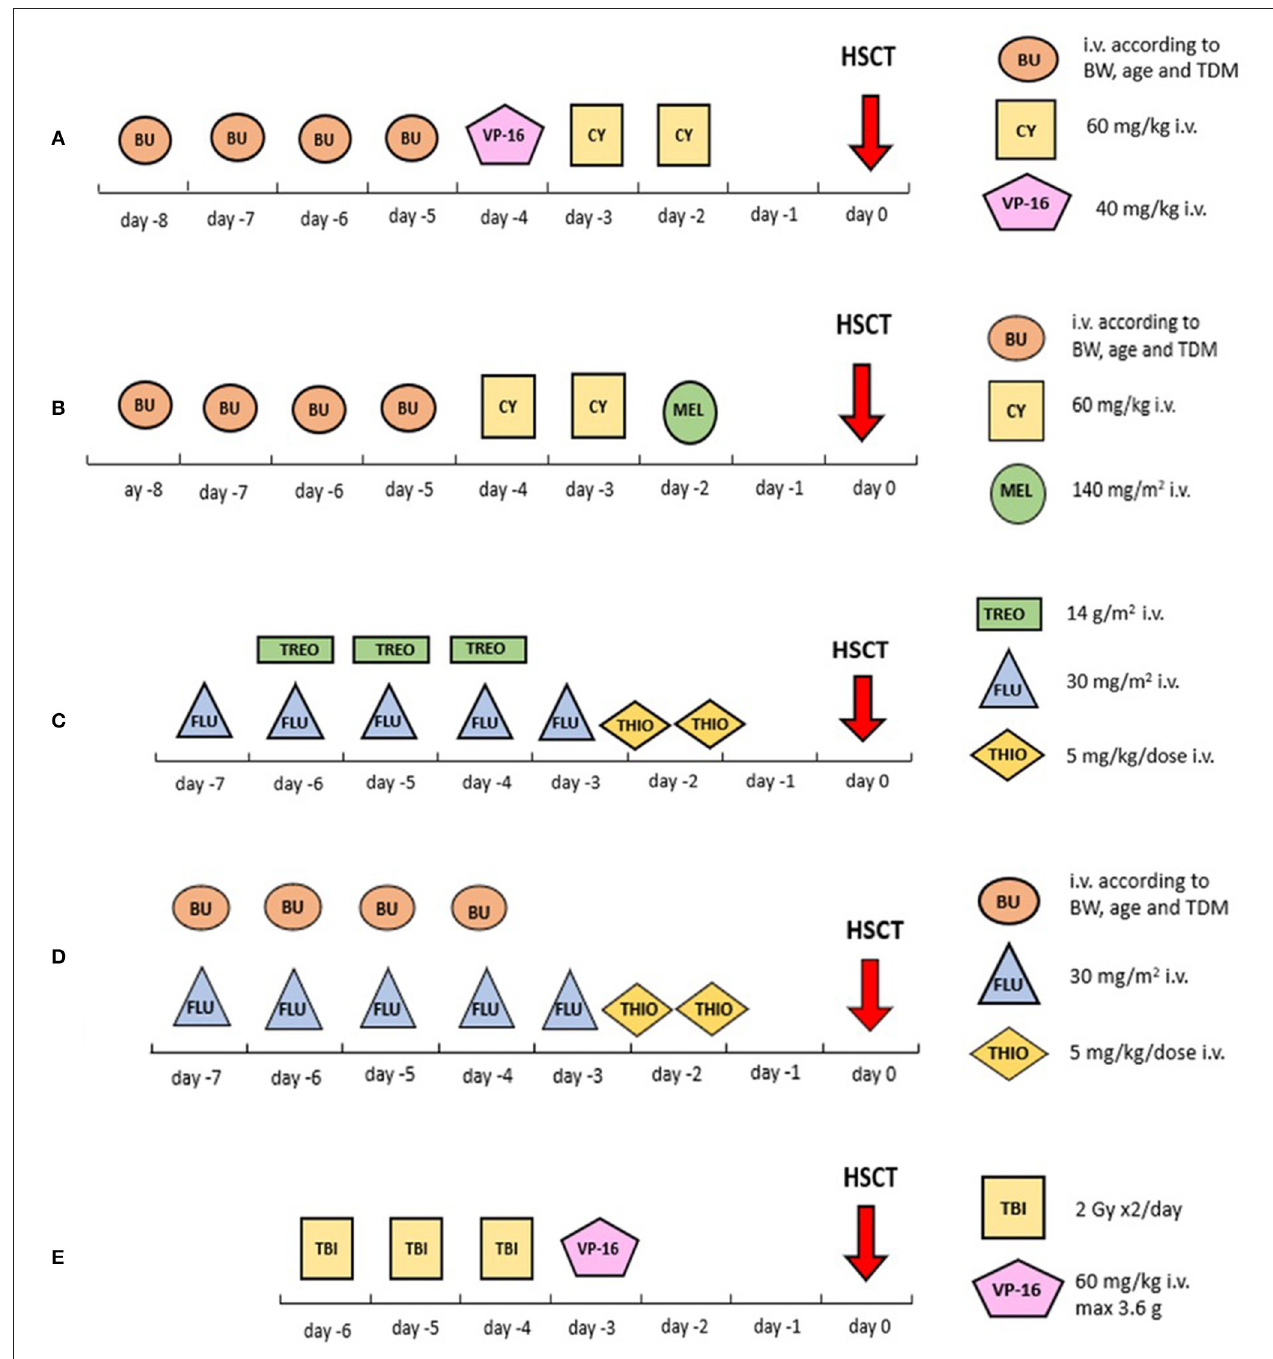
FIGURE 1 | Visual summary of the most common conditioning regimens reported in this review. (A) Busulfan associated with cyclophosphamide and etoposide; (B) busulfan associated with cyclophosphamide and melphalan; (C) treosulfan associated with fludarabine and thiotepa; (D) busulfan associated with fludarabine and thiotepa; (E) TBI plus etoposide. BU, busulfan; CY, cyclophosphamide; FLU, fludarabine; HSCT, haematopoietic stem cell transplantation; Gy, Grey; HSCT, hematopoietic stem cell transplantation; i.v., intravenous; MEL, melphalan; TBI, total body irradiation; TDM, targeted drug monitoring; THIO, thiotepa; TREO, treosulfan; VP-16,